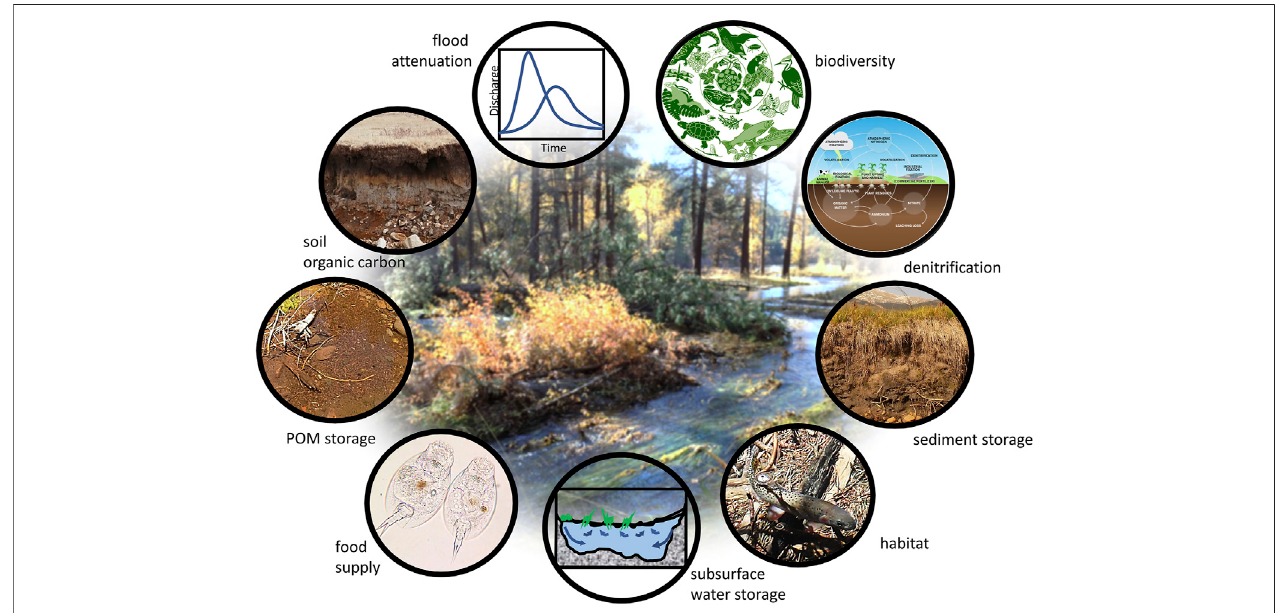
FIGURE 7| Schematic illustration of riverfunctions associated with river-wetland corridors ( “ biodiversity ” image modi fi ed from Nelson et al. (2006); “ denitri fi cation ” diagram from ibiologia.com; “ food supply ” image (rotifers) from Matthew A. Robinson, Wikimedia Commons).